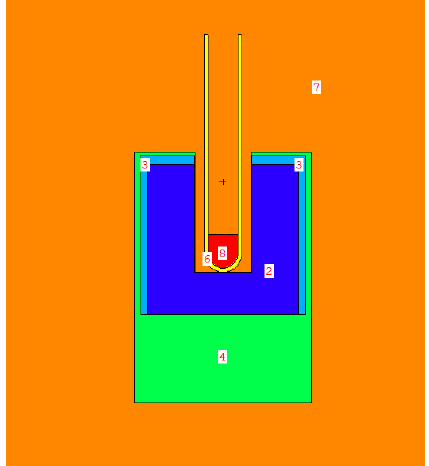
Figure 10. Geometry of the Monte Carlo model wipe test scintillator detector. Image generated using the Visual Editor software for MCNP. 2: NaI; 3: MgO; 4: Al; 6: polyethylene; 7: air; 8: H 2 0 with 225 Ac, 221 Fr, 213 Bi source distributions.